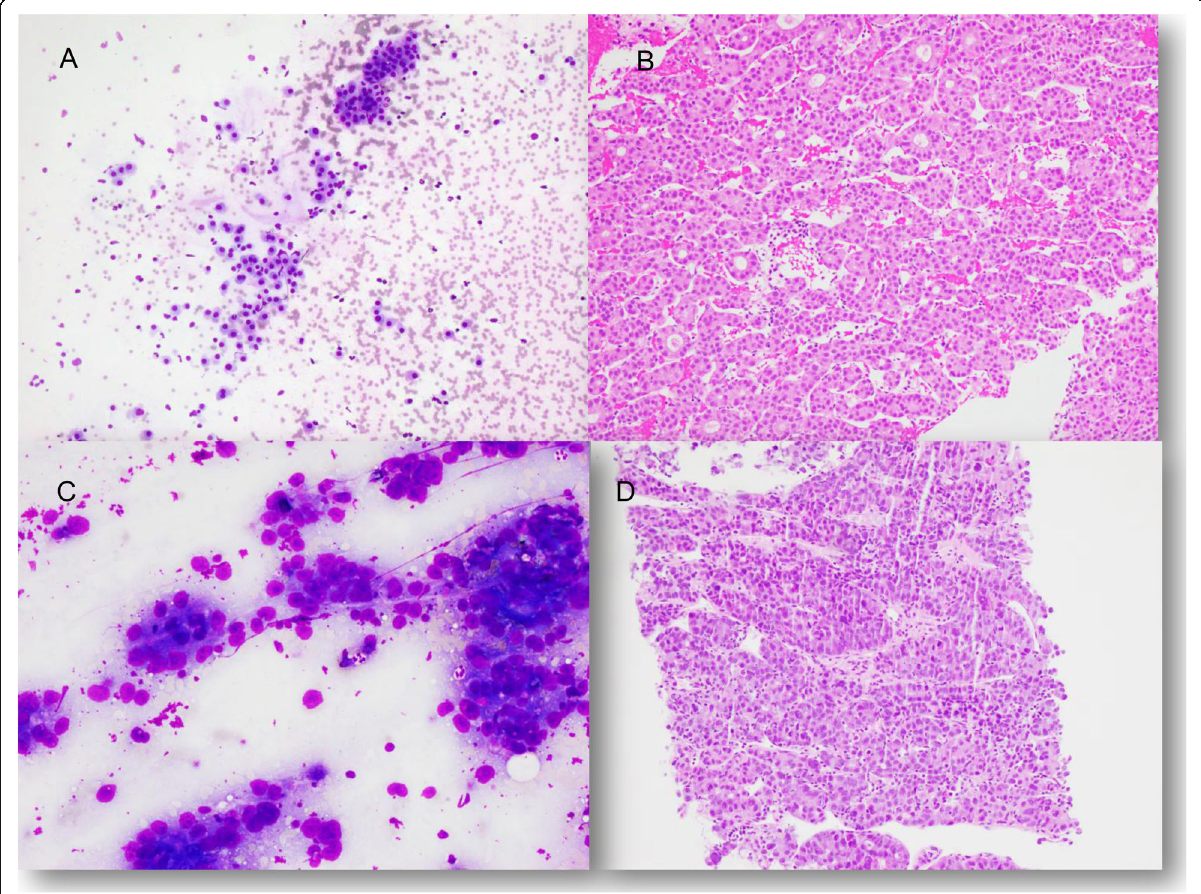
Fig. 2 a (Diff-Quik stain, 200x) and b (H&E, 100x): Well-differentiated HCC demonstrate monotonous tumor cells with slight